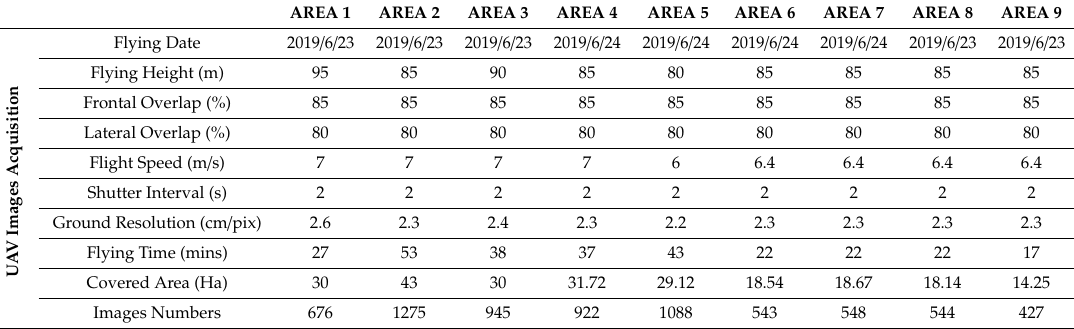
Table 1. UAV survey dates and detailed flight acquisition